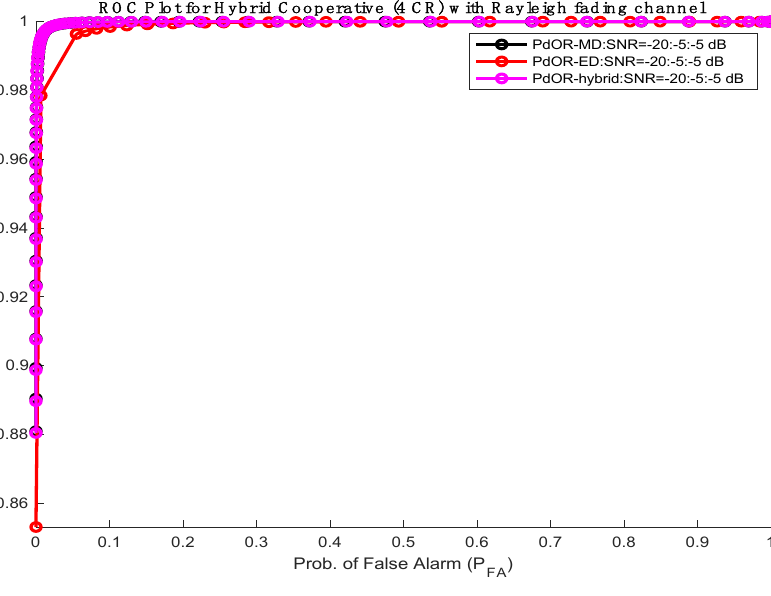
Figure 9. Hybrid detector under CSS (4): OR for case 2.